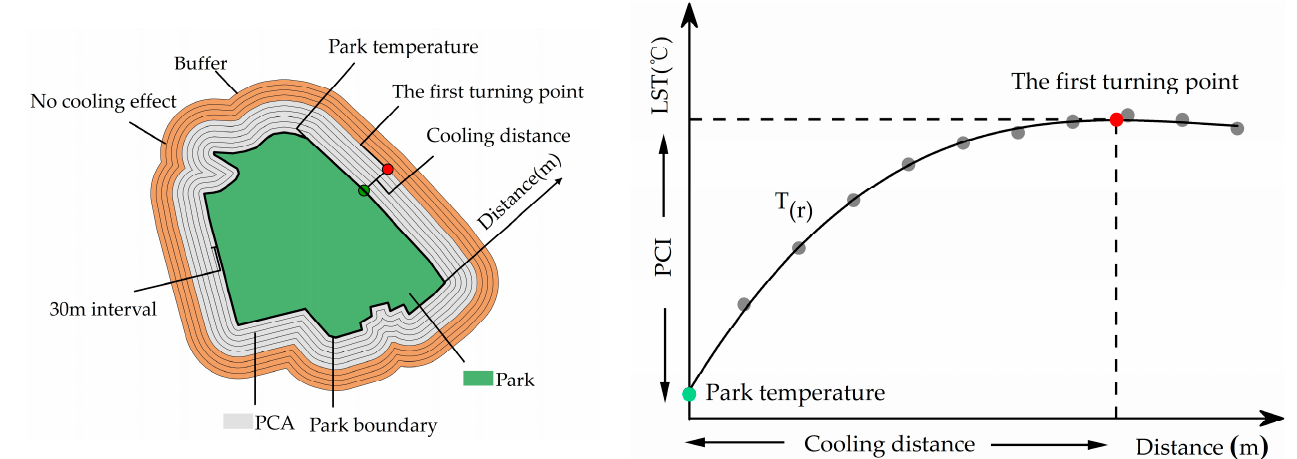
Figure 3. Sketch map of quantification method of park cooling effect.